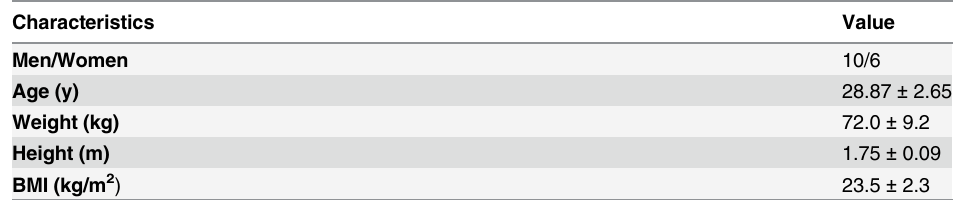
Table 1. Sample Characteristics of the study group (mean ± SD).